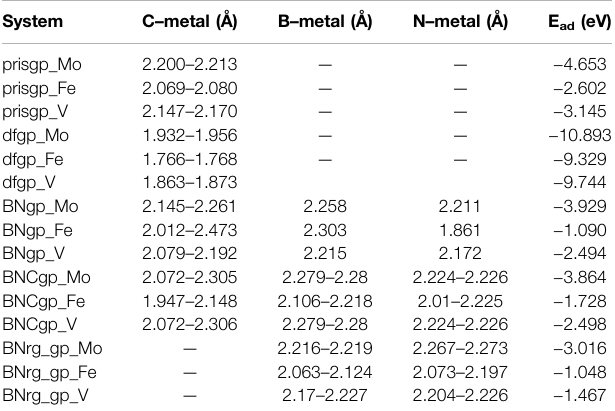
TABLE 1 | Interatomic distances and adsorption energies of Mo, Fe, and V on various graphene-based supports (pristine graphene, defective graphene, BN-doped graphene, BNC-ring graphene, BN-ring graphene, and adsorption energy are abbreviated as prisgp, dfgp, BNgp, BNCgp, BNrg_gp, and E ad